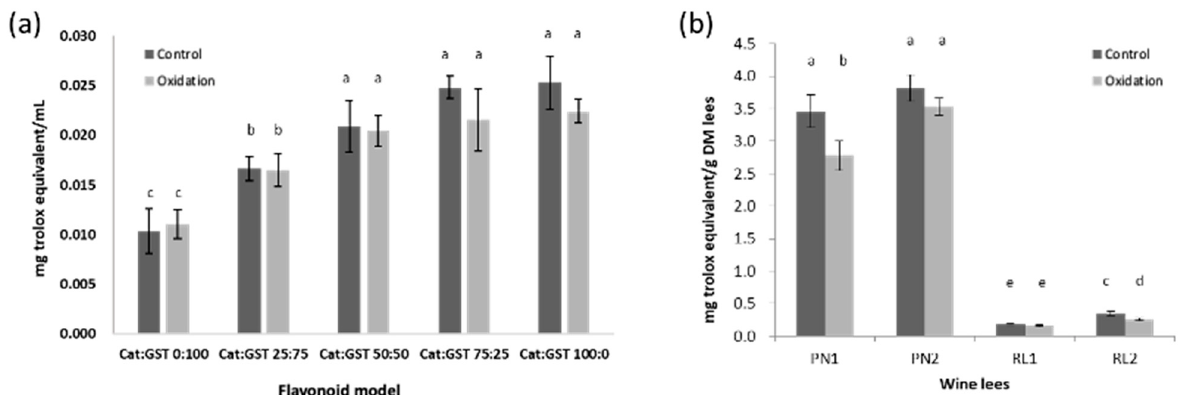
Figure 4. Oxygen radical absorbance capacity (ORAC) (mg Trolox equivalent/mL) of control and oxidized flavonoid model ( a ) and wine lees ( b ). Mean values that do not share a letter (a–e) are significantly different ( p < 0.05). Error bars are standard deviation of the replicate subsamples samples (n = 3) and measured in triplicate.